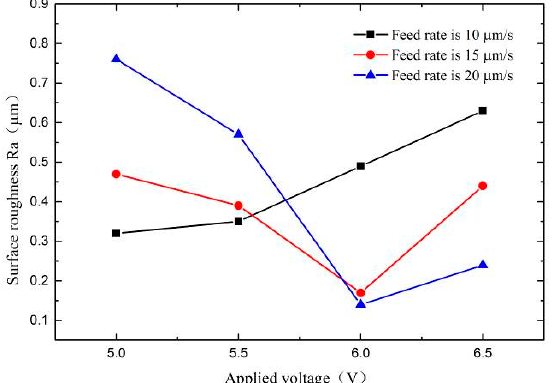
Figure 12. Variation in hole surface roughness Ra with applied voltage and feed rate.